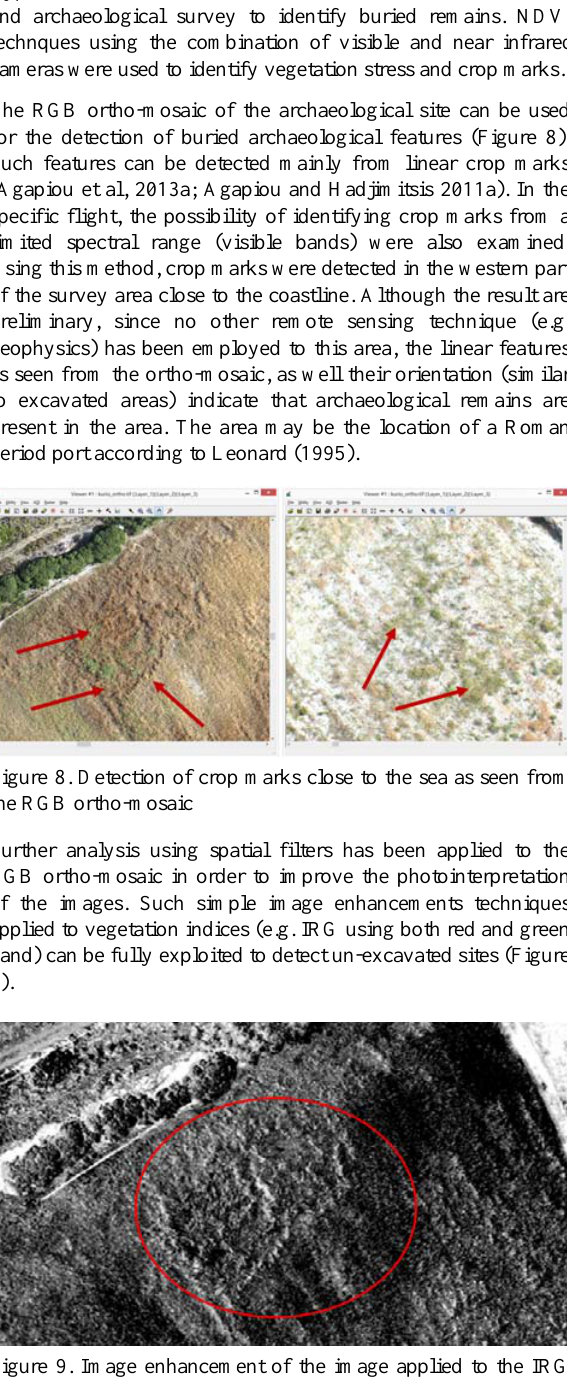
Figure 6. Results from GeoEye-1 dataset from the western part of Elis archaeological site (37°53'18.05"N, 21°22'24.48"E). (a) RGB composite; (b) NIR-R-G composite; (c) Proposed linear transformation RGB pseudo colour; (d) first component; (e) second component; (f) third component; (g) NDVI; (h) PCA composite; (i) first PCA component; (j) second PCA component and (k) third PCA component (from Agapiou et al 2013b)